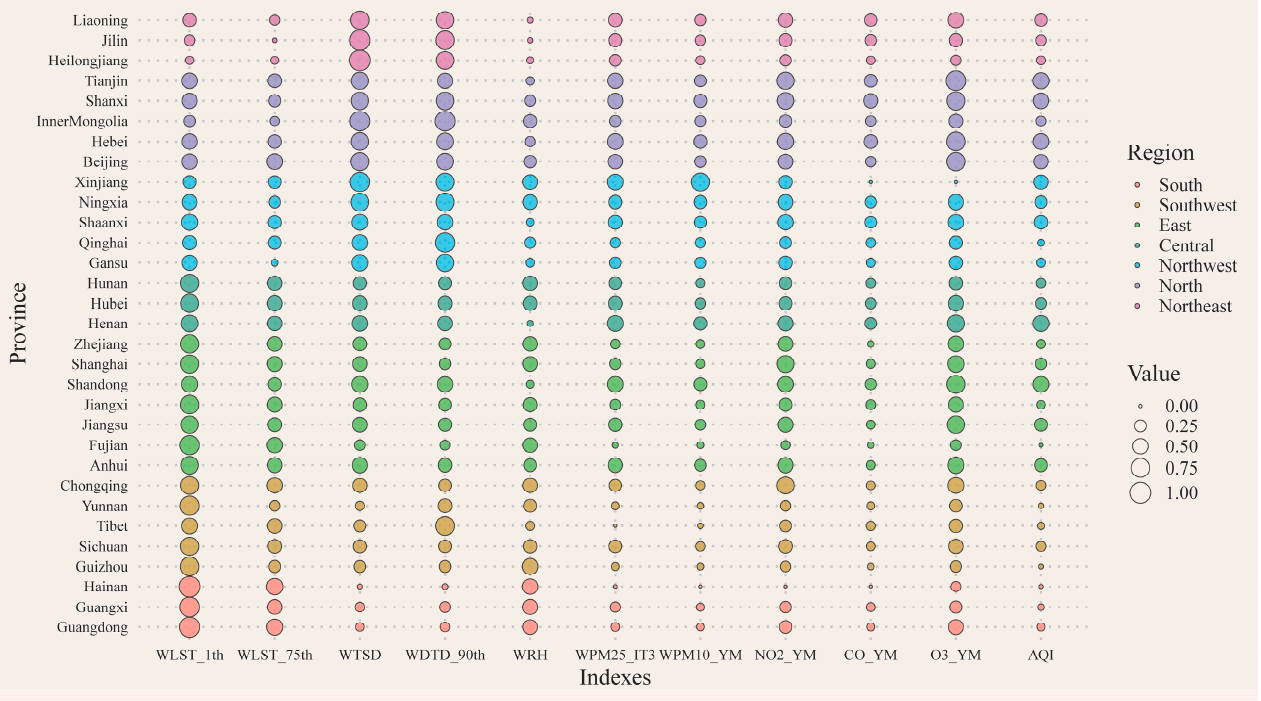
Figure 6. Distribution map of standardized values of main exposure indicators related to chronic diseases for each province. Each circle represents the standardized value of the corresponding exposure indicator for each province. The color of the circle indicates the region where the province is located, and the size of the circle indicates the value of the exposure index.